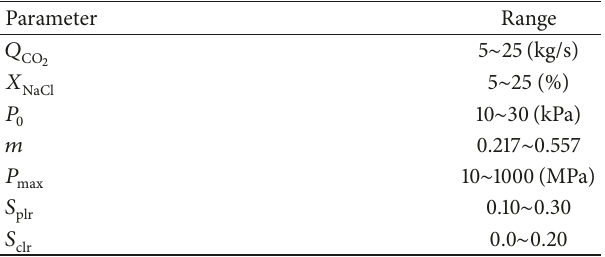
Figure 7: Relative permeability curve. Table 3: The range of